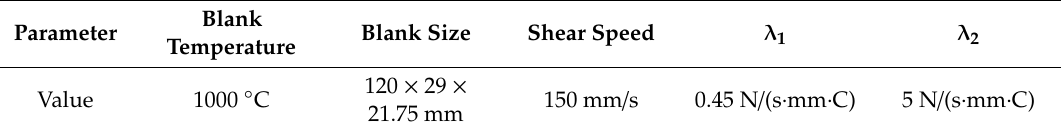
( c ) Figure 11. Dynamic recrystallized grain size: ( a ) L = 100%; ( b ) L = 125%; ( c ) L = 150%.